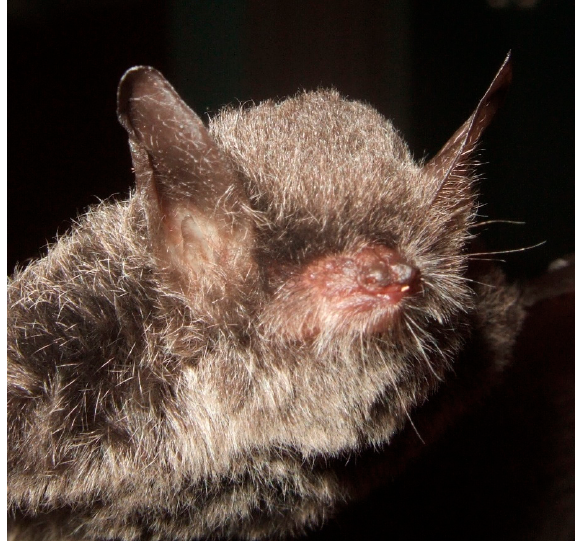
Figure 21. Myotis alticraniatus , adult male. Photograph by Vu Dinh Thong.